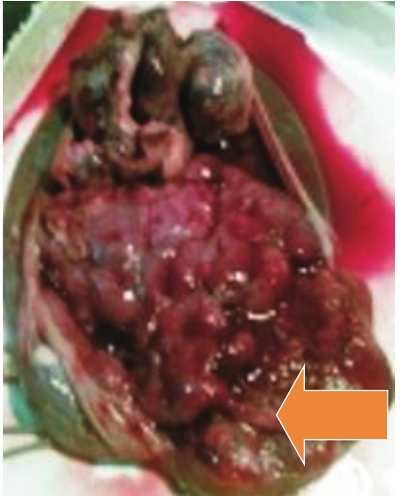
Figure 2: A huge highly vascular tumor suggestive of chorioan- gioma with placenta weighing 2 kg after delivery, arrow pointing to tumor.